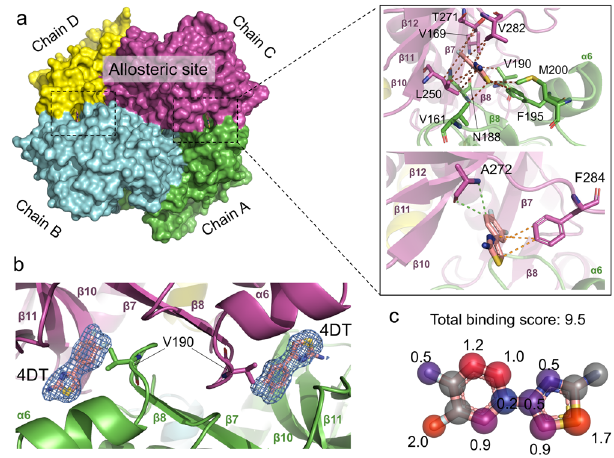
Fig. 2 4DT bind to an allosteric pocket distinct from the substrate- and NADH-binding sites. a Left: an overview of WT P f MDH tetramer with bound 4DT (pink color, sticks). Monomers are displayed as surfaces. Right: close-up of the binding site of 4DT showing interactions with the protein residues (magenta and green sticks). van der Waals, π -stacking, and other interactions are indicated in brown, orange, and green dotted lines, respectively. b Secondary structure representation of the AC interface containing two molecules of 4DT contoured as an isomesh electron density surface (omit map) contoured at 1.0 σ . The position of the V190W mutation used for the protein interference method is indicated. c Individual atomic scores within the cooperativity binding network. The score is assigned according to an increasing rank, starting with gray (neutral), blue/purple (moderate), and red